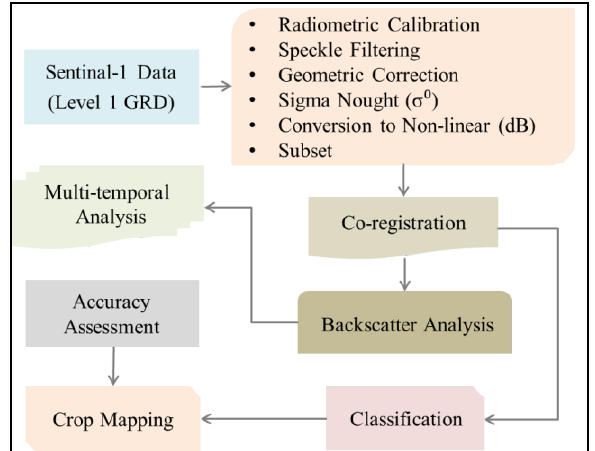
Figure 3. Workflow of multi-temporal SAR